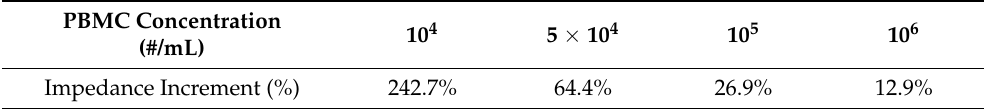
Figure 5. Photos of ( a ) Droplet incubation in the stationary model; ( b ) Impedance changes of CD-45 antibody against PBS buffer (no cell present, blank control), IL-6 antibody against PBMCs (negative control), and CD-45 antibody against PBMCs (target). The concentrations of the cell suspensions were 10 6 per mL. ( c ) a droplet trajectory in the dynamic incubation mode (1 cycle); (colored fluid was used for better visualization); ( d ) The relationships between the concentration of PBMCs and the corresponding impedance changes of the integrated EIS sensor in stationary and dynamic modes. The error bars represent the standard deviation of n = 5. Table 2. Comparison of impedance increment (dynamic vs. stationary modes) at different PBMC concentrations.